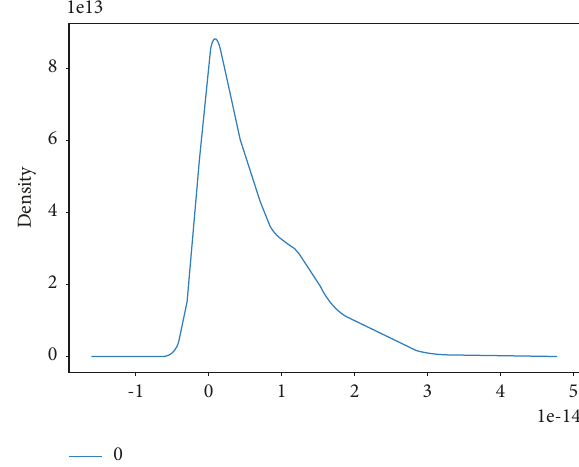
Figure 3: Probability of multivariate Gaussian with Gaussian pyramid 7 ×